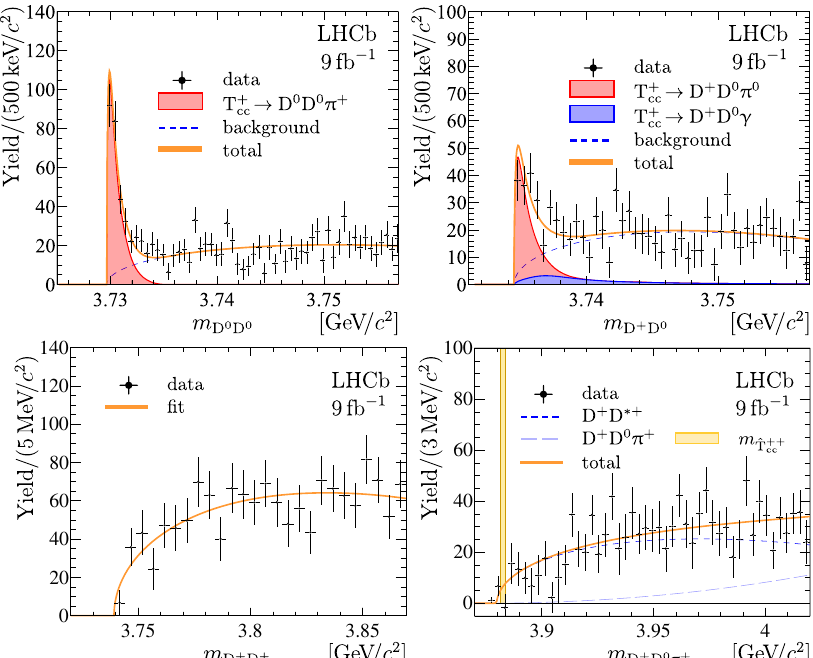
Fig. 4 Mass distributions for selected D 0 D 0 , D + D 0 , D + D + and D + D 0 π + combinations. (Top) DD and DD π + mass distributions for selected (left) D 0 D 0 and (right) D + D 0 candidates with the non-D background subtracted. The overlaid fi t results are described in the text. For visibility theT þ ! D þ D 0 γ component. (Bottom) Mass distributions for selected (left) D + D + and (right) D + D 0 π + candidates with the non-D stacked on top of the T þ cc background subtracted. The vertical coloured band indicates the expected mass for the hypothetical ^ T only functions are described in the text. Uncertainties on the data points are statistical only and represent one standard deviation, calculated as a sum in quadrature of the assigned weights from the background-subtraction procedure.